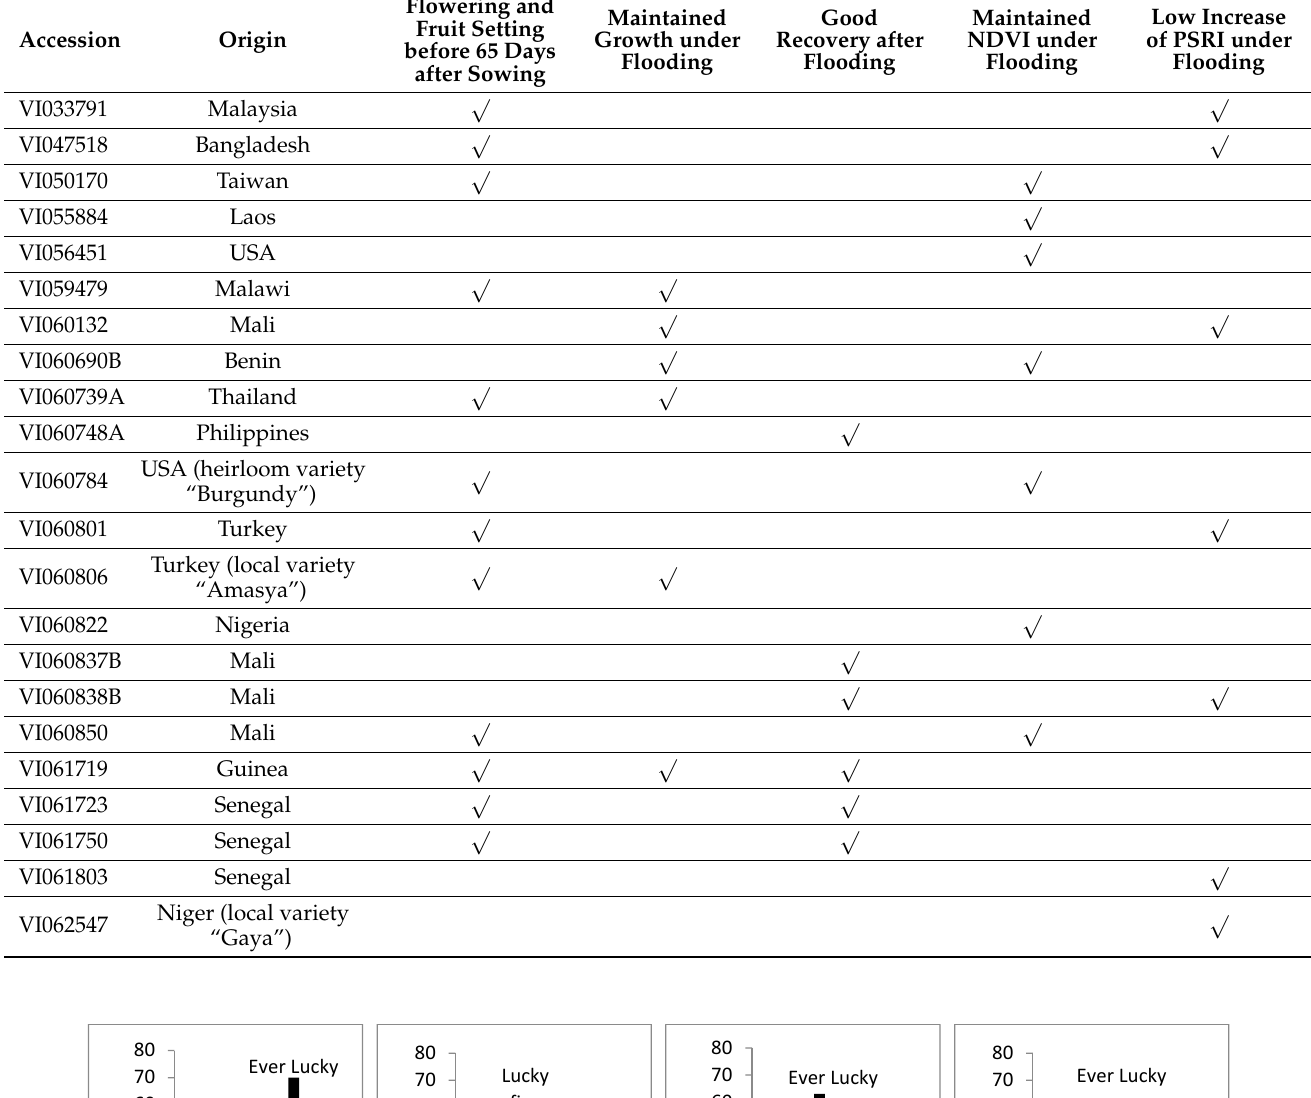
Table 2. Flooding tolerant candidate accessions.